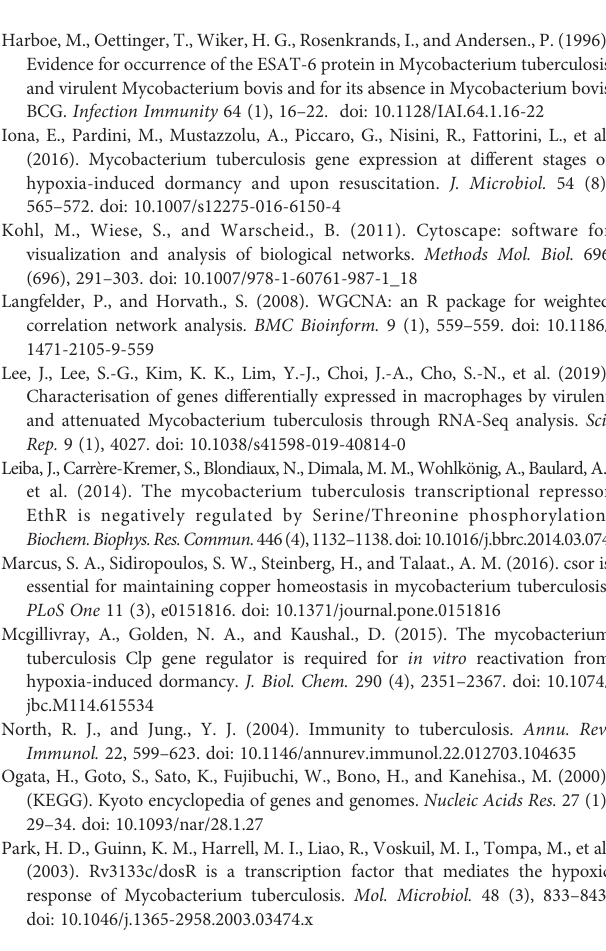
SUPPLEMENTARY FIGURE 1 | Growth curve of M. marinum after reaeration from hypoxic cultures. SUPPLEMENTARY TABLE 1 | Detailed information on the differentially expressed gene list at different time periods. SUPPLEMENTARY TABLE 2 | List of genes identi fi ed in 12 gene modules by WGCNA analysis. SUPPLEMENTARY TABLE 3 | Primer sequences of genes analyzed by